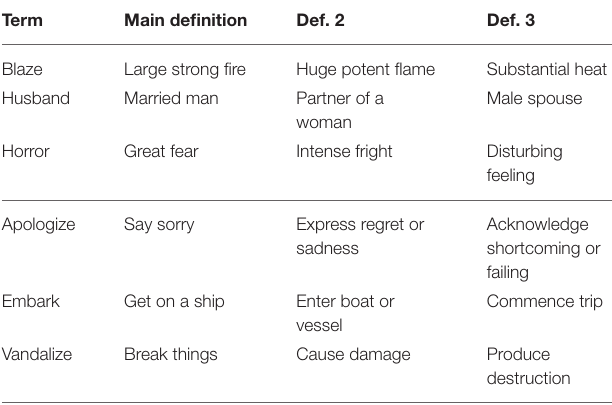
TABLE 5 | Sample of the dataset for the term/definition comparison task, cited from Kartsaklis et al. [26].